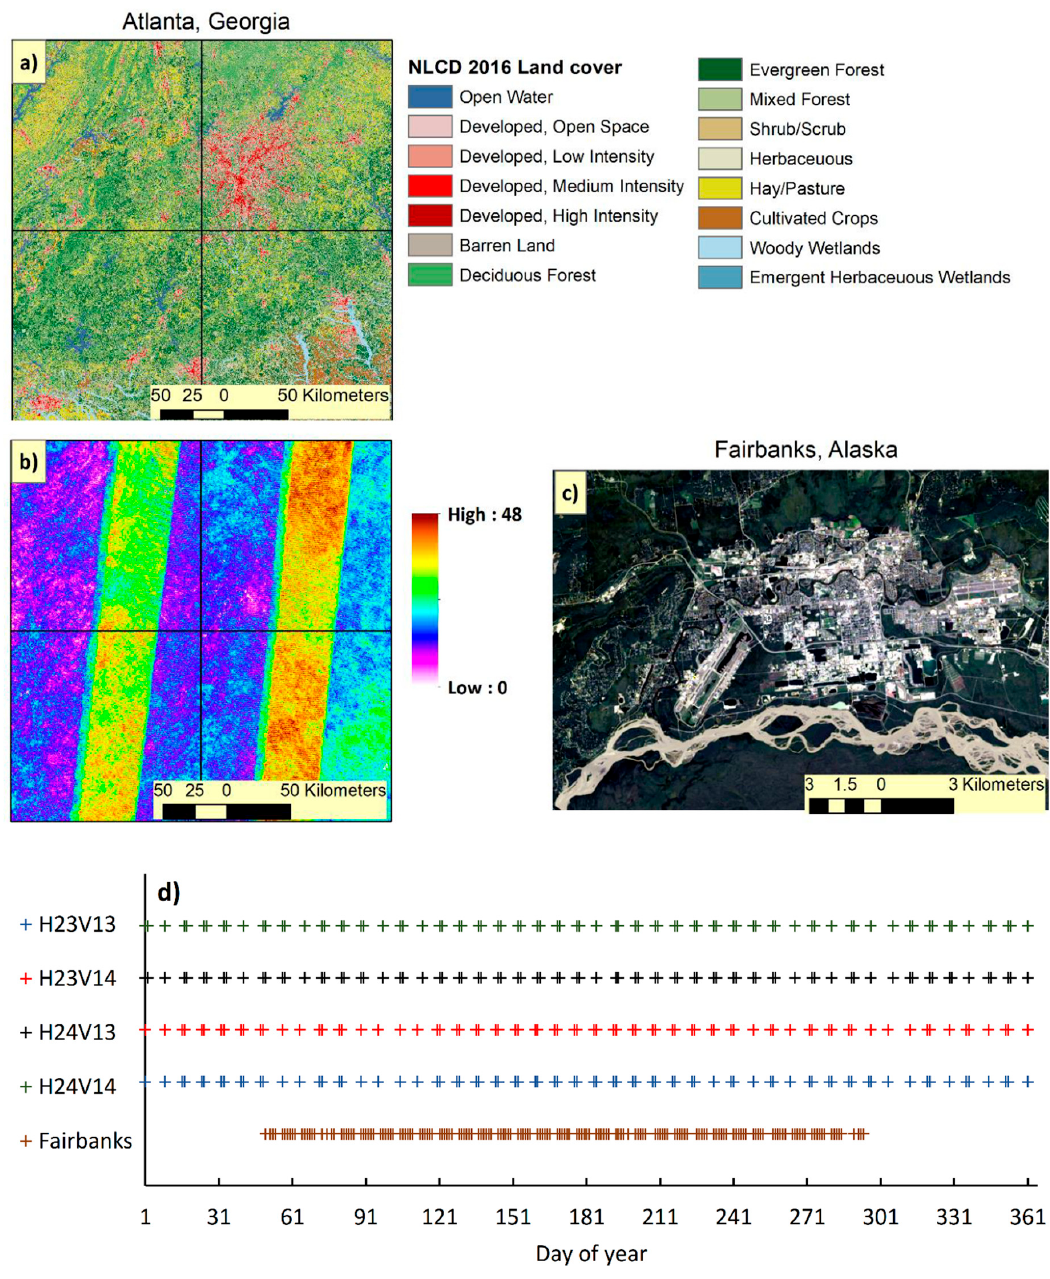
Figure 1. The first study area is Atlanta, Georgia. Panel ( a ) shows land cover types from National Land Cover Database (NLCD) 2016. The black lines are boundaries of the four Analysis Ready Data (ARD) tiles (Top left: H23V13, top right: H23V14, bottom left: H24V13, bottom right: H24V14). Panel ( b ) shows the number of clear observations based on the ARD pixel QA band. Panel ( c ) shows the second study area in Fairbanks, Alaska. The background image is the true color combination of ARD Landsat 8 on July 6, 2017. Panel ( d ) shows the Landsat acquisition dates in each tile.